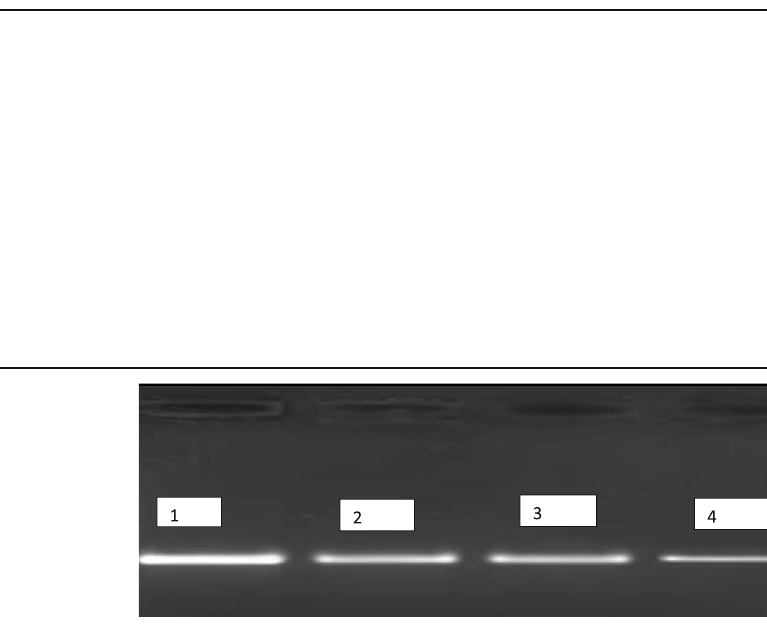
Fig. 15 Gel image showing DNA of the kidney